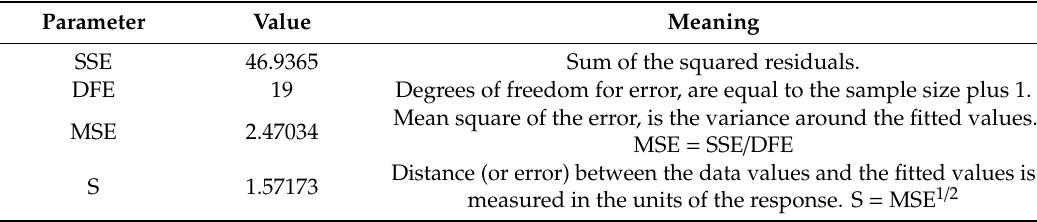
Table 4. Statistical summary of the model